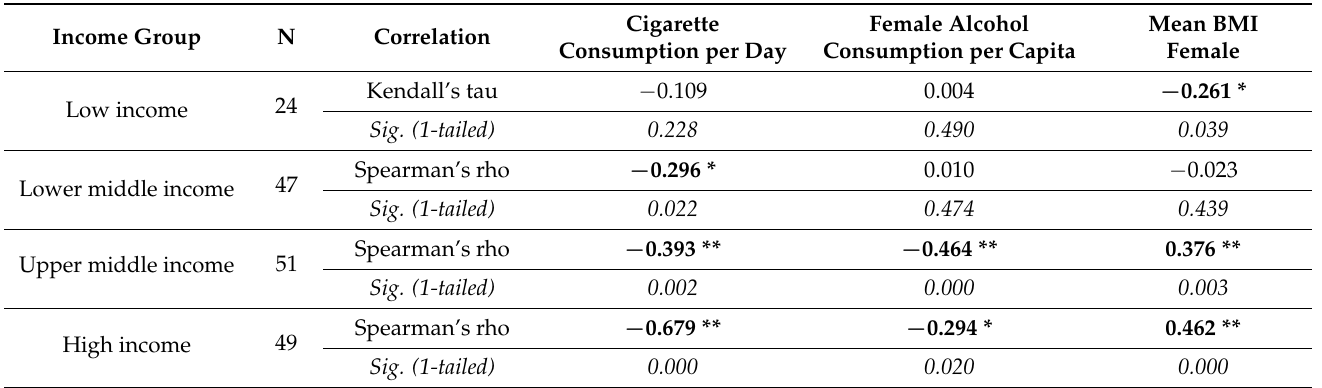
Table 3. Bivariate correlations between birthrate and each independent